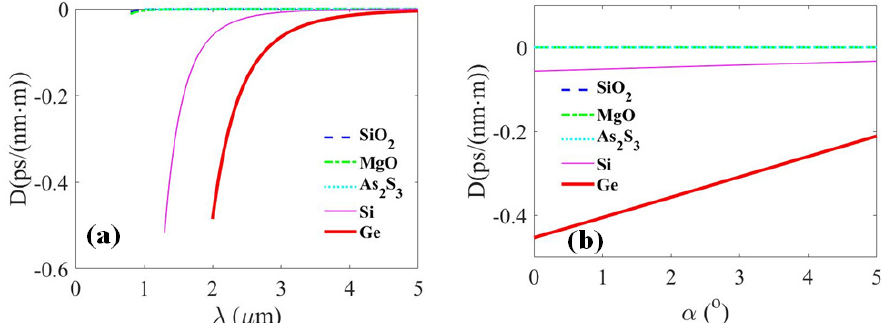
Figure 4. Dispersion constants of typical infrared materials: ( a ) Varying with wavelength ( α = 0.5 ◦ ); and ( b ) varying with propagation angle ( λ = 2.05 µ m). The blue dashed line, green dash-dotted line, cyan dotted line, pink thin solid line and red thick solid line represent the optical materials SiO 2 , MgO, As 2 S 3 , Si, and Ge,